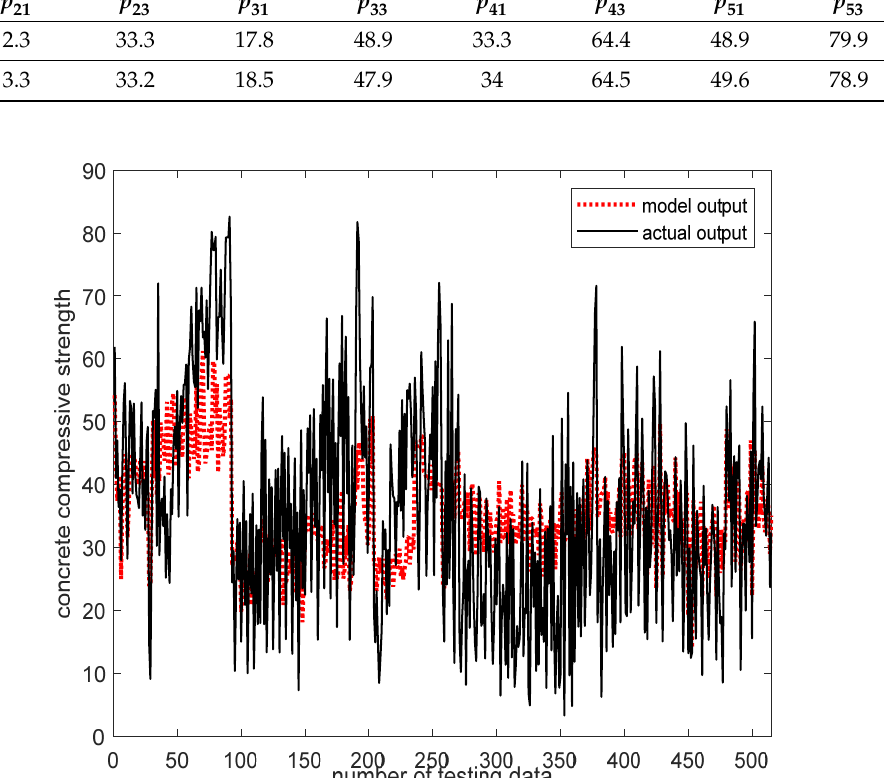
Figure 13. Comparison between the output of the optimized CGK-based fuzzy granular model and the real output.